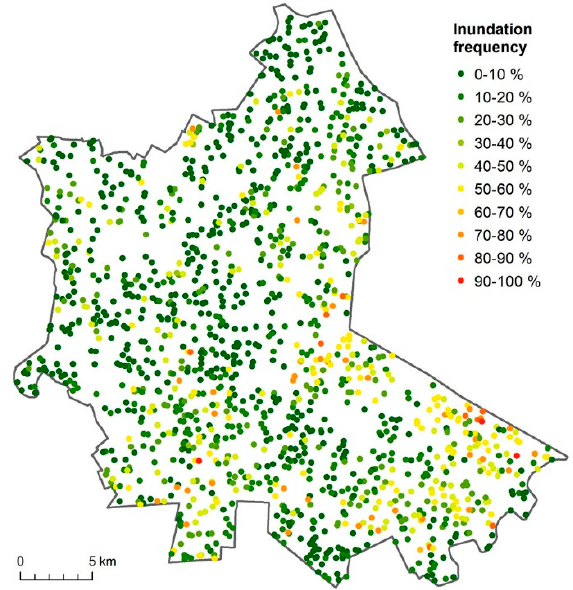
Figure 3. The 1451 locations of the validation dataset.